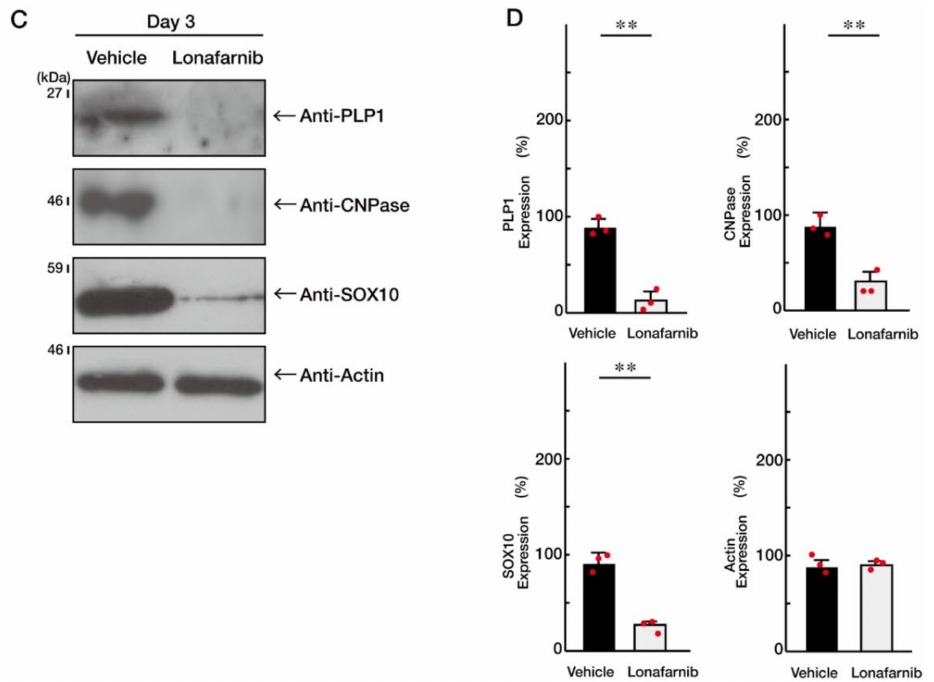
Figure 6. Ras inhibition inhibits oligodendroglial cell morphological differentiation. ( A , B ) FBD- 102b cells were treated with vehicle or Lanafamib (5 µ M) and were allowed to be differentiated for 0 or 3 days. Differentiation efficiencies were divided into three categories and depicted in graphs (**, p < 0.01; n = 5 fields). The number of branches in cells is also counted and shown (**, p < 0.01; 50 cells). ( C , D ) Cells at 3 days following the induction of differentiation were collected, lysed, and immunoblotted with an antibody against PLP1, CNPase, SOX10, or actin. Immunoreactive band intensities were also compared to be depicted in graphs (**, p < 0.01; n = 3 blots).